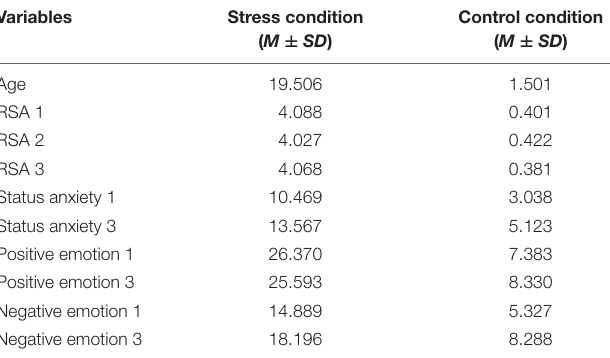
TABLE 1 | Characteristics of physical and psychological stress responses ( n =